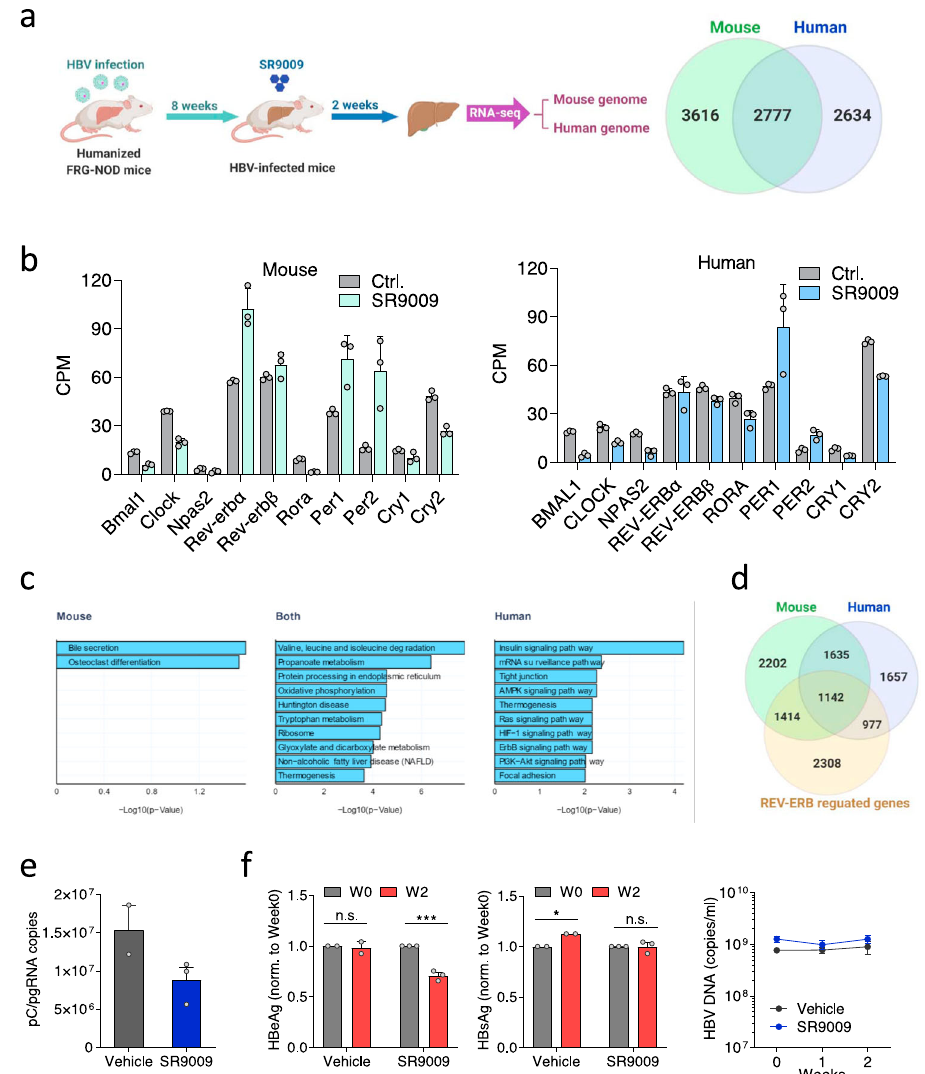
Fig. 6 Pharmacological activation of REV-ERB modulates the human transcriptome and inhibits HBV BCP transcription in vivo. a Fah − / − , Rag2 − / − , IL2Rg − / − , non-obese diabetic (FRG-NOD) mice transplanted with primary human hepatocytes were infected with 10 9 HBV genome equivalents puri fi ed from concentrated supernatant of the HepG2.2.15 cell line (HBV genotype D subtype ayw). Eight weeks later mice were treated twice a day by intraperitoneal injection of either vehicle or 100 mg/kg SR9009 for 2 weeks. At the end of experiment, mouse livers were collected for RNA-seq analysis and sequence reads mapped to the human or mouse genome. Differential expressed genes (DE) in human and mouse cells (19 of the DE genes in mouse had no human ortholog match). b Differentially expressed core clock genes in mouse and human. The counts per million (CPM) of the key clock genes assigned to the two genomes in the control and treated group are shown (mean ± SD, n = 3 independent liver samples). c Human KEGG pathway analysis of differentially expressed genes in mouse only, both mouse and human, and human only sets. Negative log10 adjusted p -values are given and top 10 signi fi cant (adjusted p -value <0.05) pathways shown. d Overlap of differentially expressed genes from SR9009 treated mouse livers with REV-ERB regulated genes. e Total RNA from mouse livers were extracted and HBV pC/pgRNA levels measured by qRT-PCR. Data are expressed relative to vehicle treated group (mean ± SEM, n = 2 for vehicle group and 3 for SR9009 group). f Peripheral HBeAg, HBsAg and HBV DNA levels were quanti fi ed (mean ± SEM, n = 2 for vehicle group and 3 for SR9009 group, Two way ANOVA analysis). * p < 0.05, ** p < 0.01, *** p <0.001. Data are provided in the accompanying Source Data fi